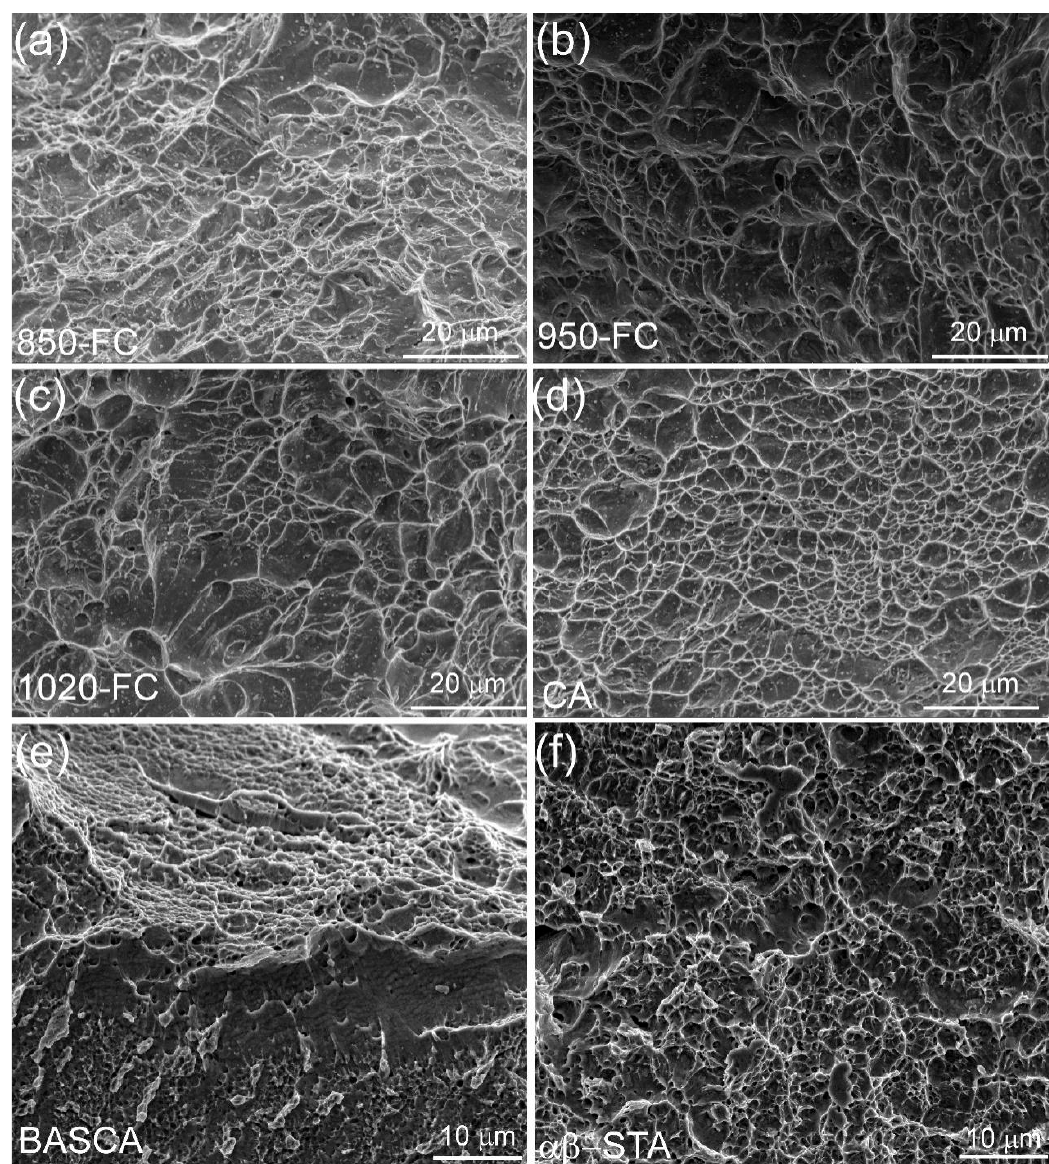
Figure 10. High magnification fractographs of samples ( a ) 850-FC, ( b ) 950-FC, ( c ) 1020-FC, ( d ) CA, ( e ) BASCA and ( f ) αβ -STA samples.